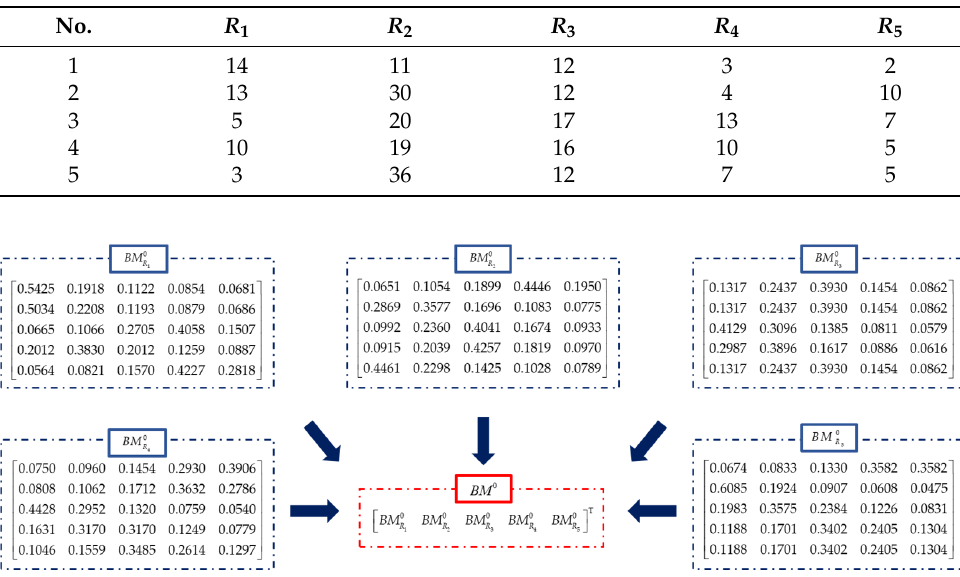
Table 3. Data of rock mass for model validation.